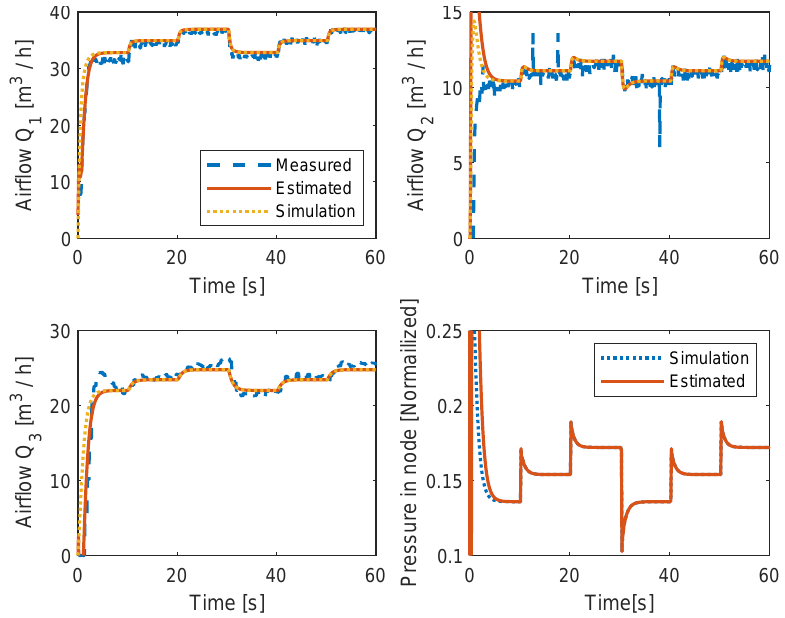
Figure 7. State estimation with an Extended Kalman